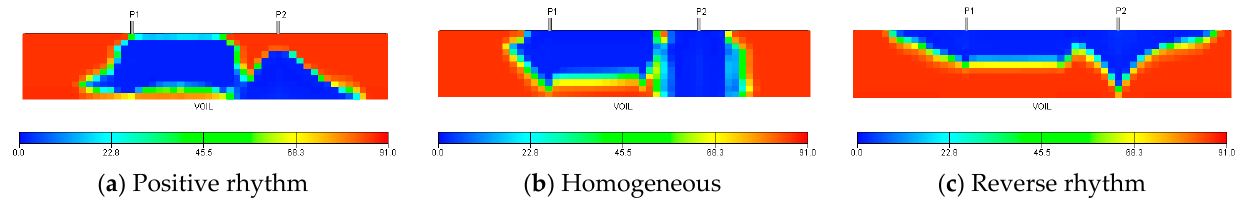
Figure 9. Viscosity distribution diagram after well stuffy.